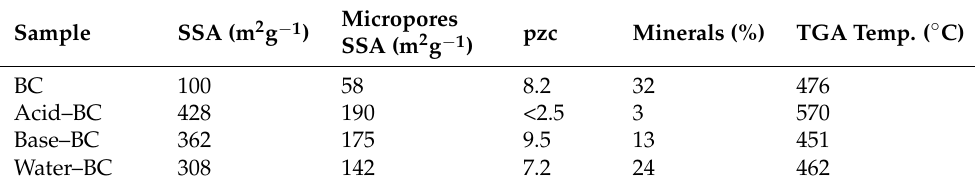
Table 1. Physicochemical properties of the starting and modified biochars.